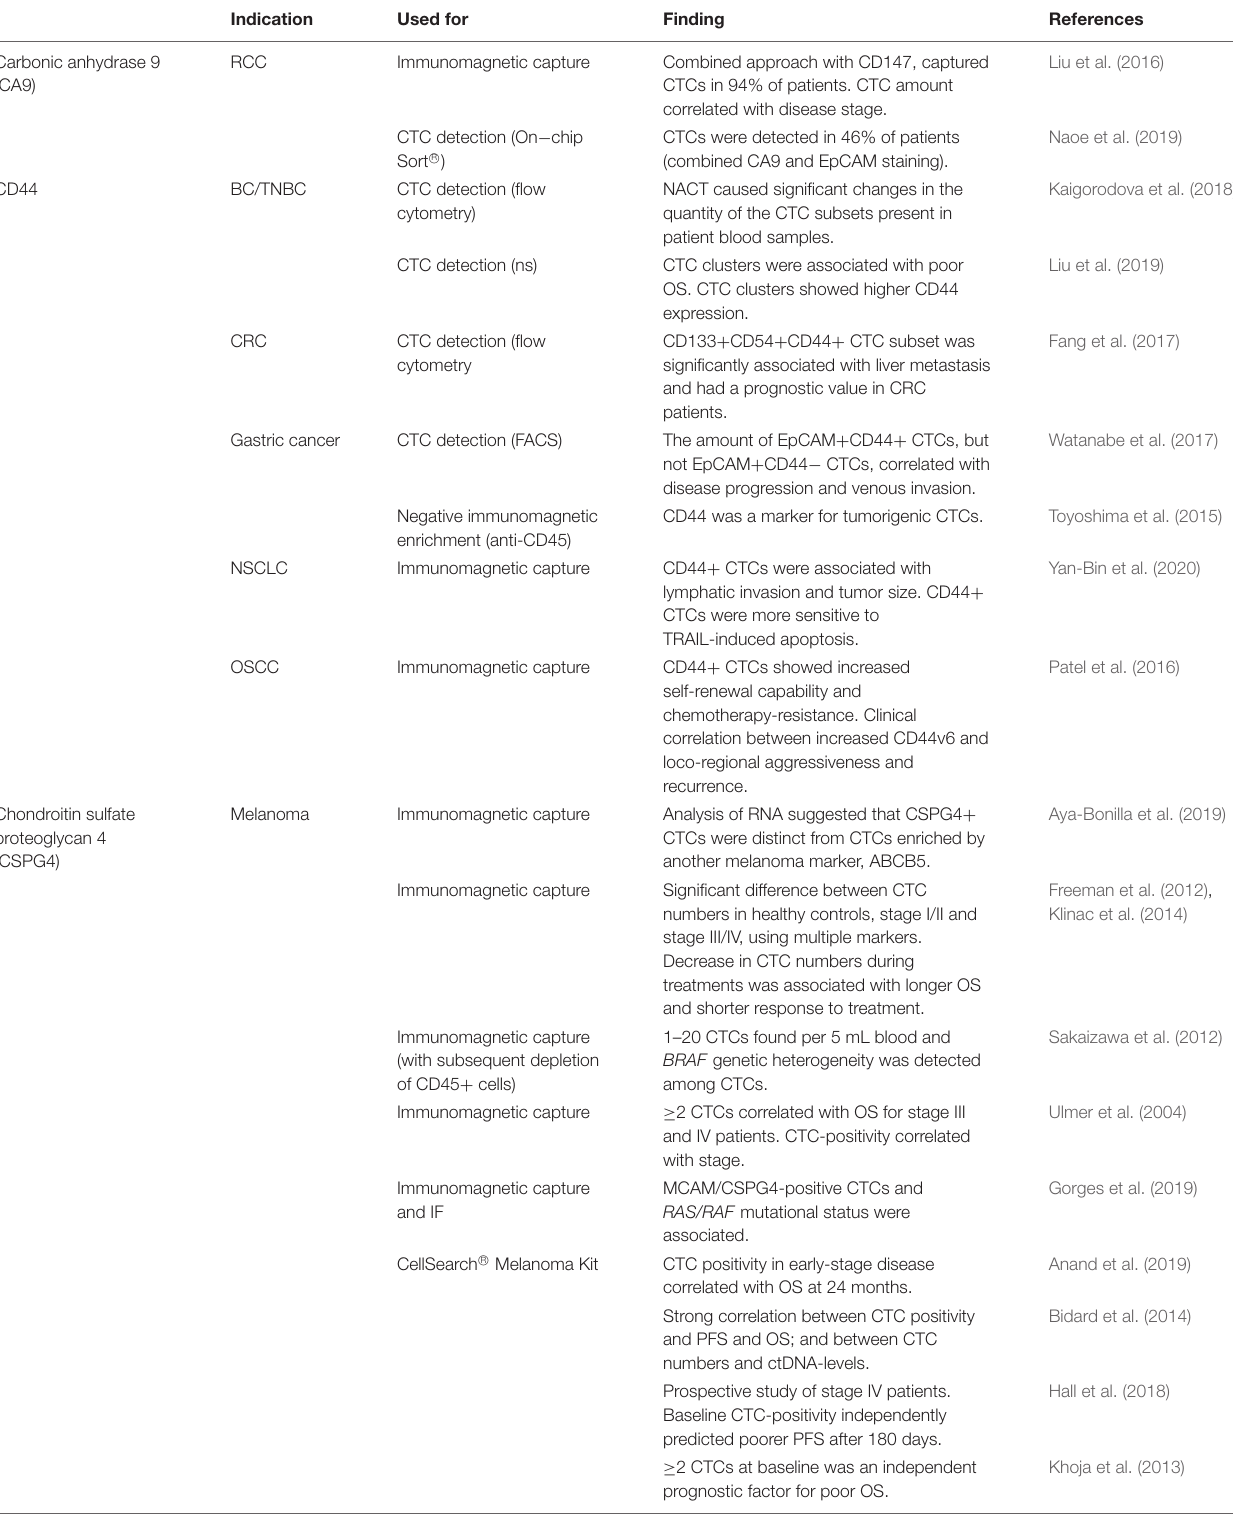
TABLE 1 | Proteoglycans used for isolation or identification of clinical circulating tumor